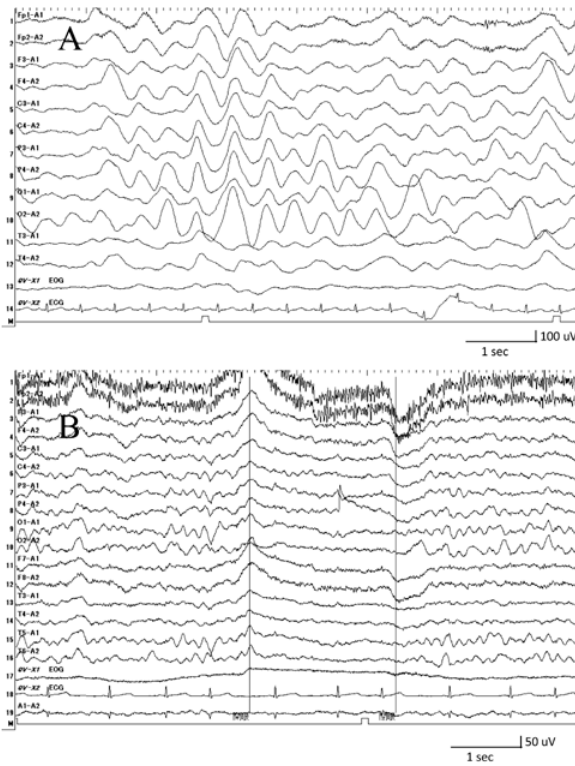
Figure 3: Electroencephalograms A: Slow waves of activity in all brain regions, especially in the occipi- tal lobe, were observed on day 8 of illness B: Abnormal waves were recovered on day 18 of illness.